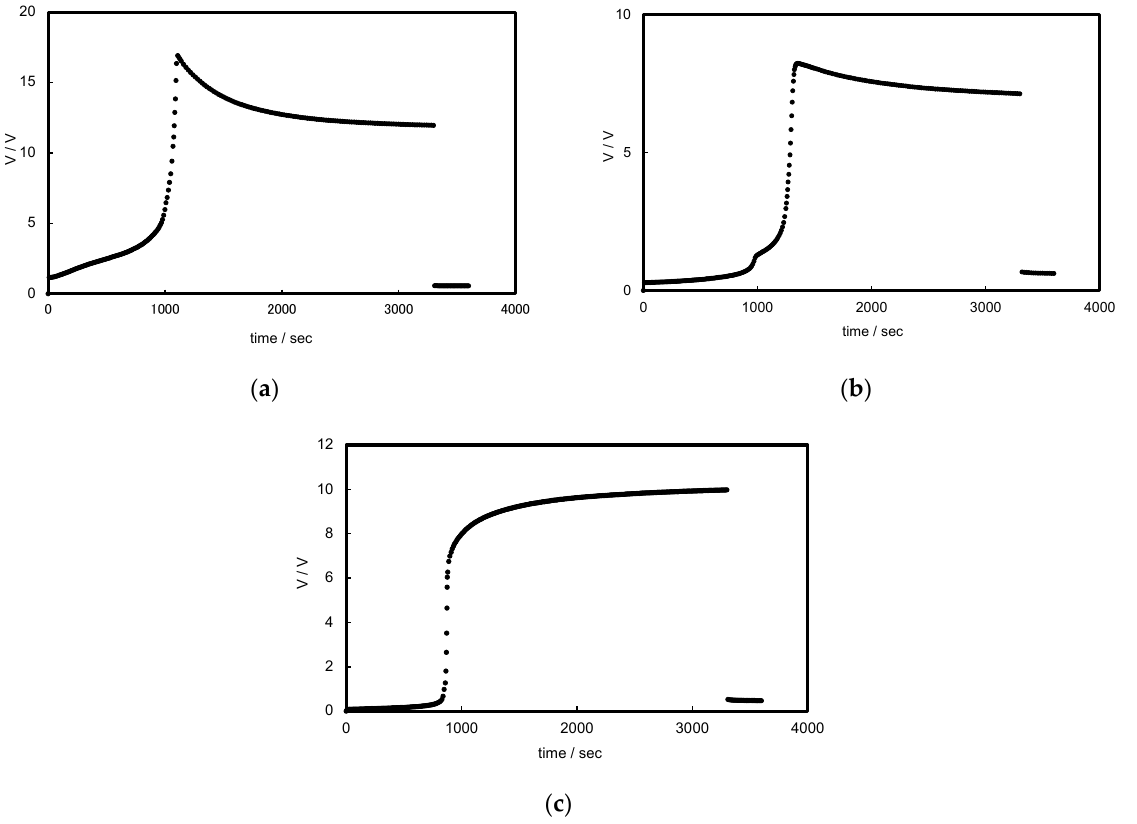
Figure 2. Typical chronopotentiometric responses for ( a ) BPM/EtOH, ( b ) BPM/Et(OH) 2 , and ( c ) BPM/FA systems at the constant current density of 0.16 mA cm − 1 .